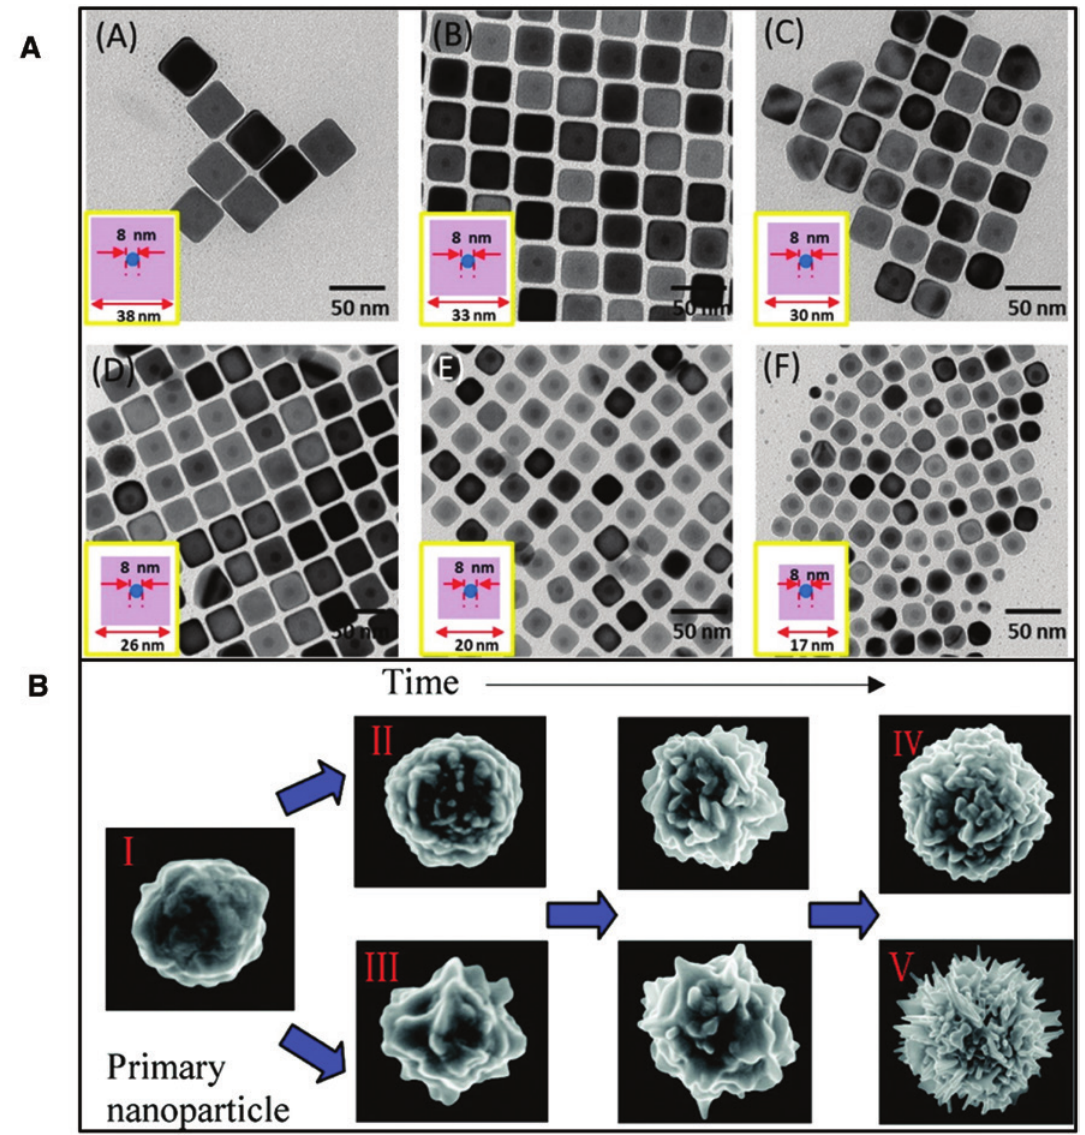
Figure 1: (A–F) TEM images of AuNS@Ag nanocubes obtained by adding (A) 0.15 ml, (B) 0.2 ml, (C) 0.5 ml, (D) 1.0 ml, (E) 2.0 ml, (F) 3.0 ml of AuNS into Ag shell growth solution. Inset of (A–F) shows schematic illustration of AuNS@Ag nanocube (not to scale). Adapted from Liu et al. Chem. Mater. 2015a , 27 , 5261–5270. Copyright © 2015 American Chemical Society. (B) SEM images of Au mesostructures with a variety of surface topographies. Types I–V, synthesized at various conditions. Adapted from Fang et al. Nano Lett . 2010 , 10 , 5006–5013. Copyright © 2010 American Chemical